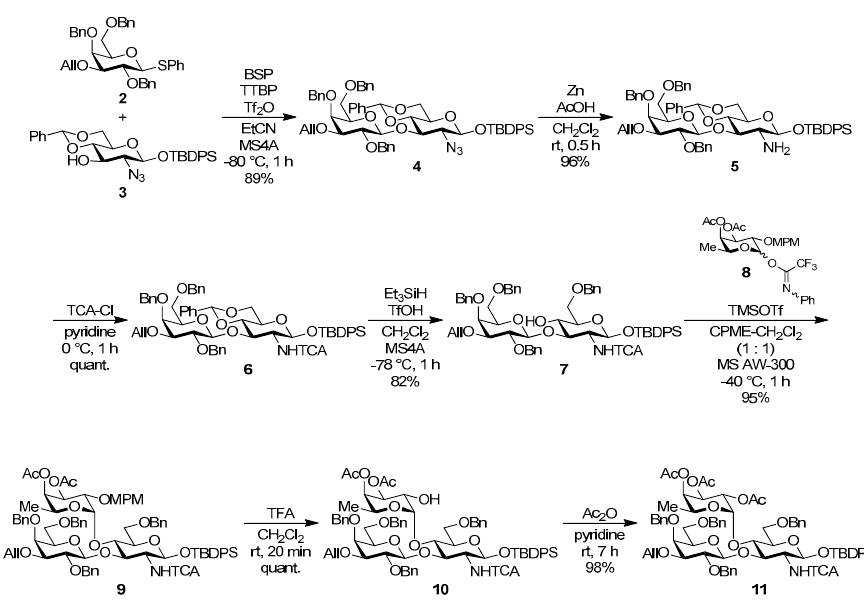
Scheme 2. Synthesis of the Le a trisaccharide common intermediate.